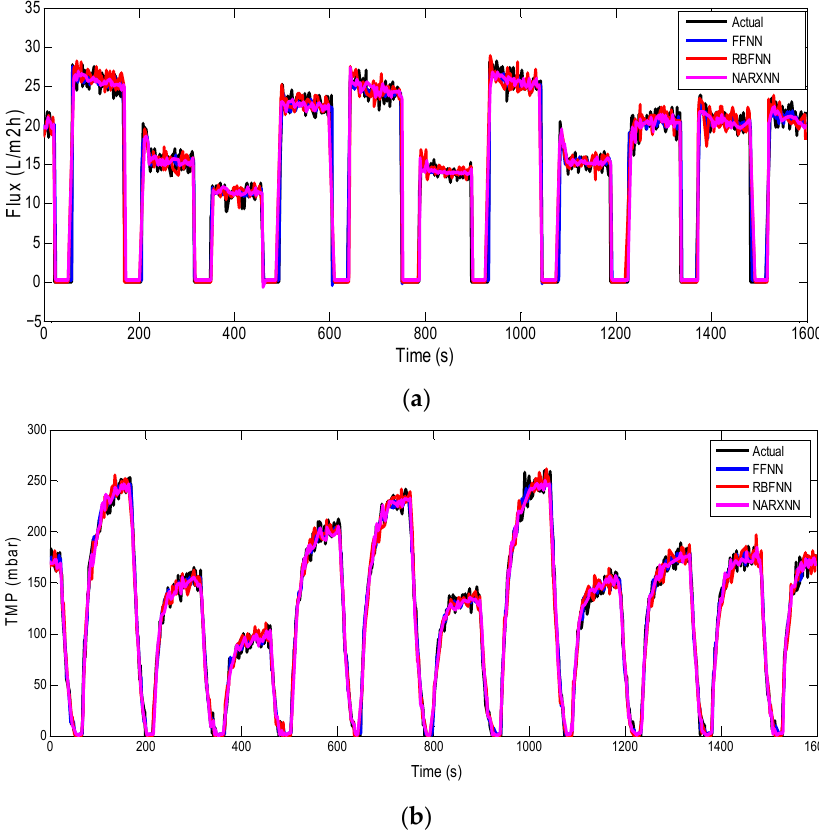
Figure 14. Testing models for ( a ) flux; ( b ) TMP. Table 2. Performance evaluation for training results.